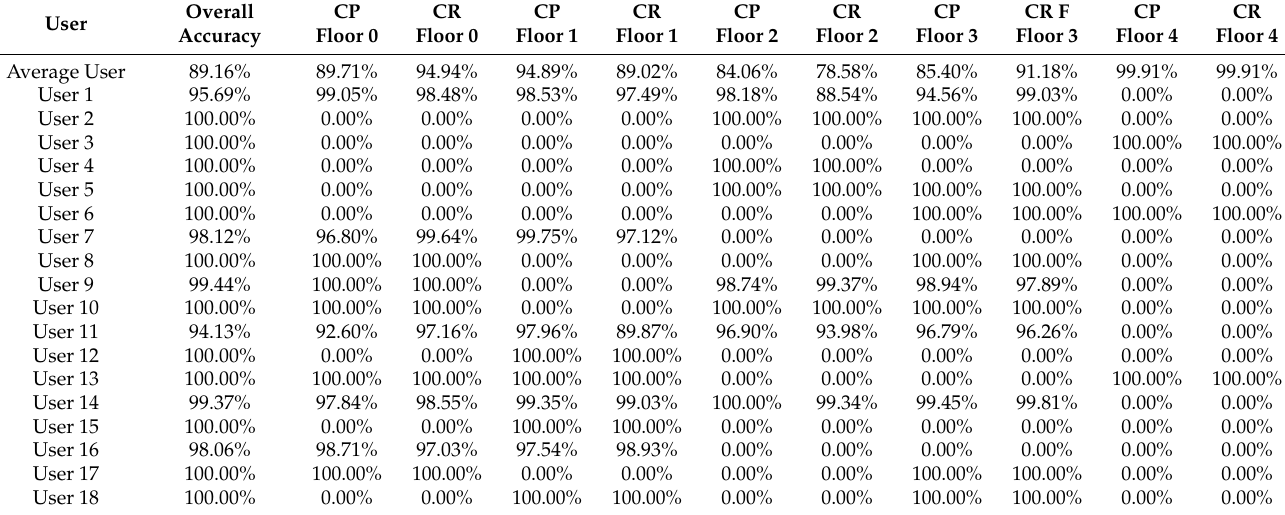
Table 3. Summary of results for performing indoor localization in terms of indoor floor detection by modeling specific users and their associated user